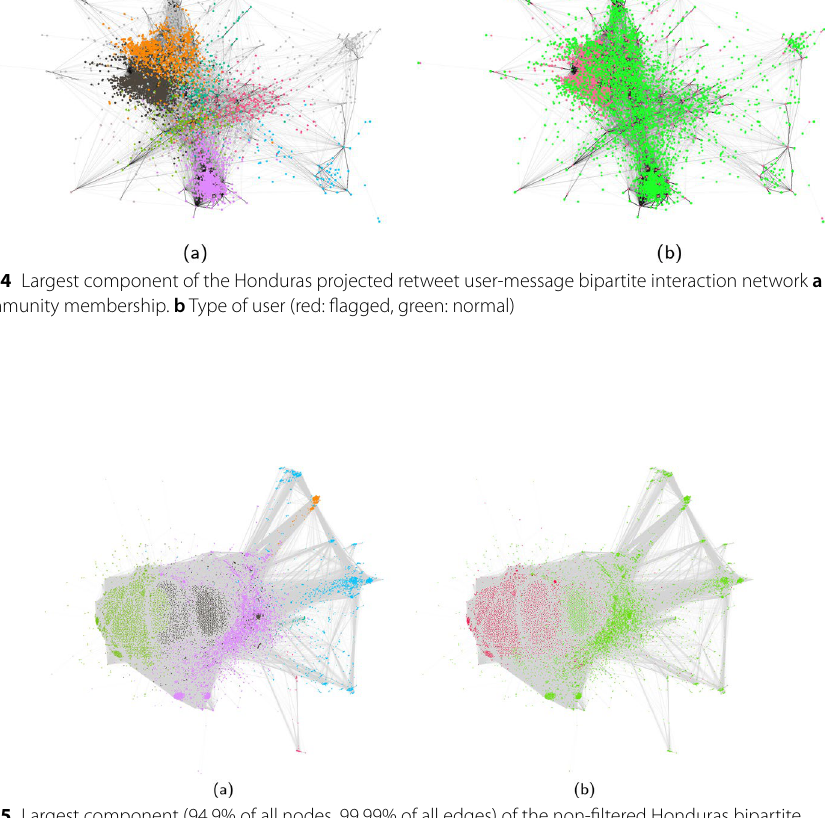
Fig. 5 Largest component (94.9% of all nodes, 99.99% of all edges) of the non-filtered Honduras bipartite user-hashtag network projected on the user layer. a Community membership. b Type of users (red: flagged, green: